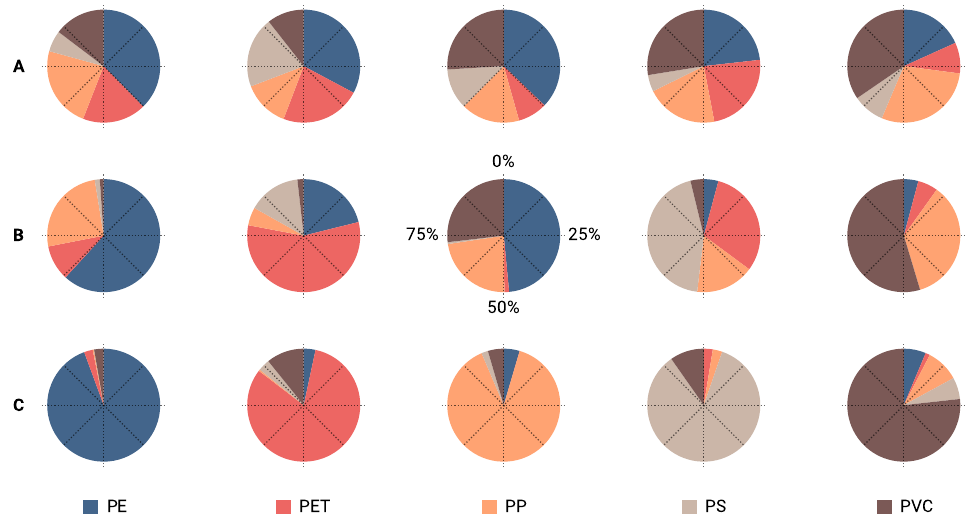
Figure 14. True positives and false negatives per plastic type over all backgrounds using noise- free signals classified with RF, where ( A ) are of PlanetScope, ( B ) are of WorldView-3, and ( C ) are of